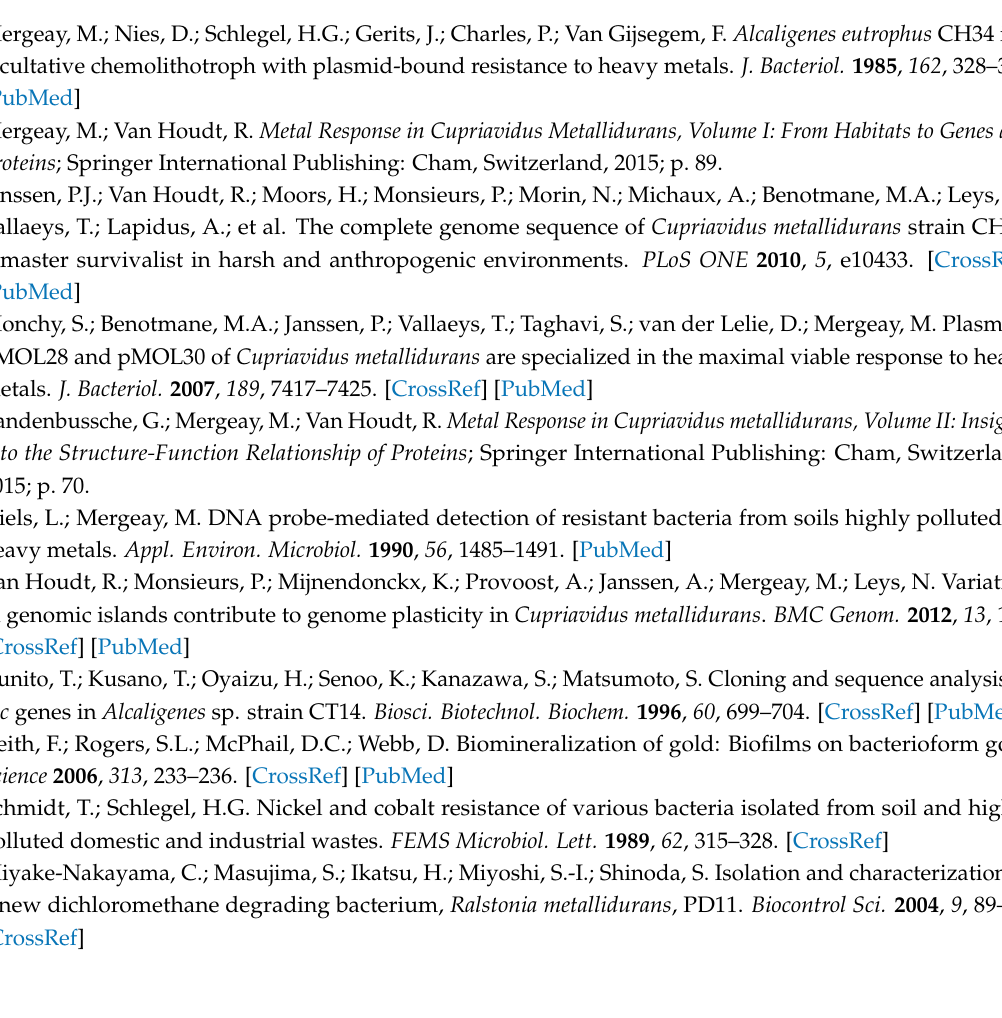
Figure S1: Density plot of the AUC values of all PM reactions for each strain, Figure S2: Progressive Mauve alignment of CMGI-1 of CH34 with related elements in NA1, NA4 and H1130, Table S1: Metal concentrations used in growth experiments, Table S2: Primers used in this study, Table S3: Pan-genome analysis data set, Table S4: PM area under the curve (AUC)